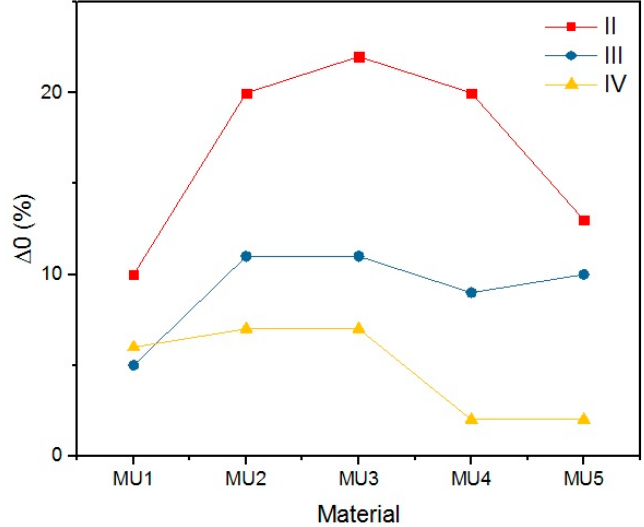
Figure 23. The shape change for materials that rested at 20 °C (I) or 4 °C (II–IV) which were programmed at different temperatures (I and II, 60 °C; III, 80 °C; and IV, 90 °C).